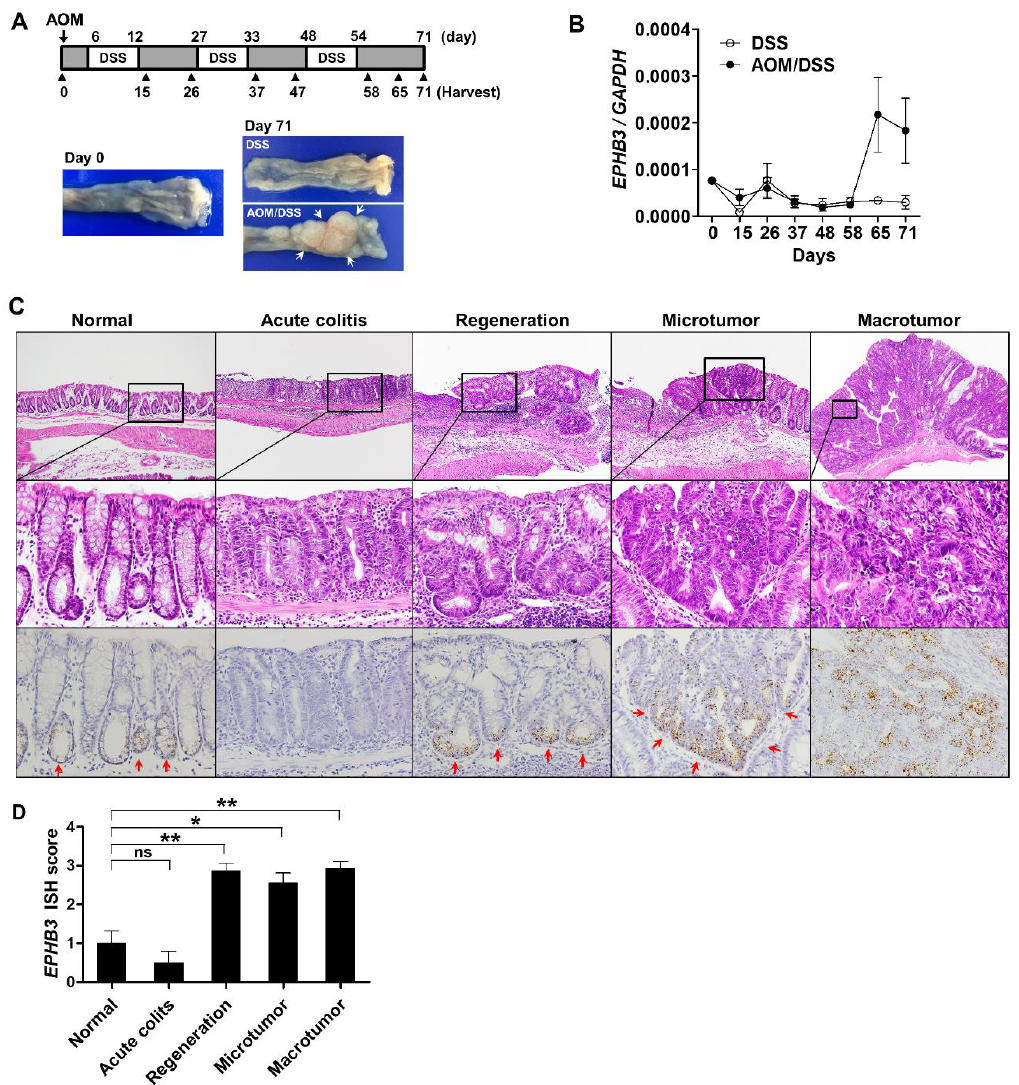
Figure 5. Expression of EPHB3 in colitis-associated carcinogenesis (CAC). ( A ) Colitis-associated colon cancer was induced by azoxymethane and dextran sodium sulfate (AOM / DSS). At each day indicated by black arrow heads, mice (DSS: n = 4, AOM / DSS: n = 5) were sacrificed for analysis. Representative photos of colons harvested on day 0 and day 71 show visible tumors indicated by white arrows. ( B ) Real-time PCR analysis revealed increased EPHB3 expression on days 65 and 71. ( C , D ) RNA in situ hybridization for EPHB3 expression during colitis-associated colon cancer development. Data represent the means ± SEM. SEM: standard error of the mean. * p < 0.05, ** p <